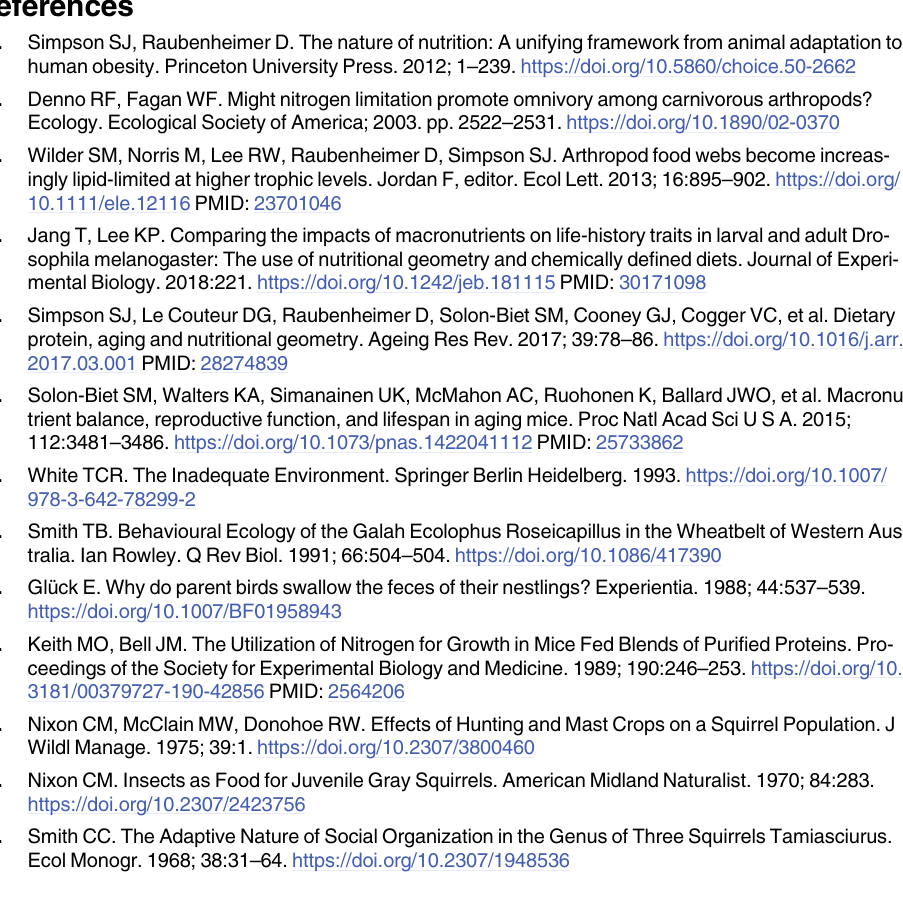
S2 Fig. Exome matching profiles from diverse species, including a bacterium, yeast, flies, corn, mouse, and human.